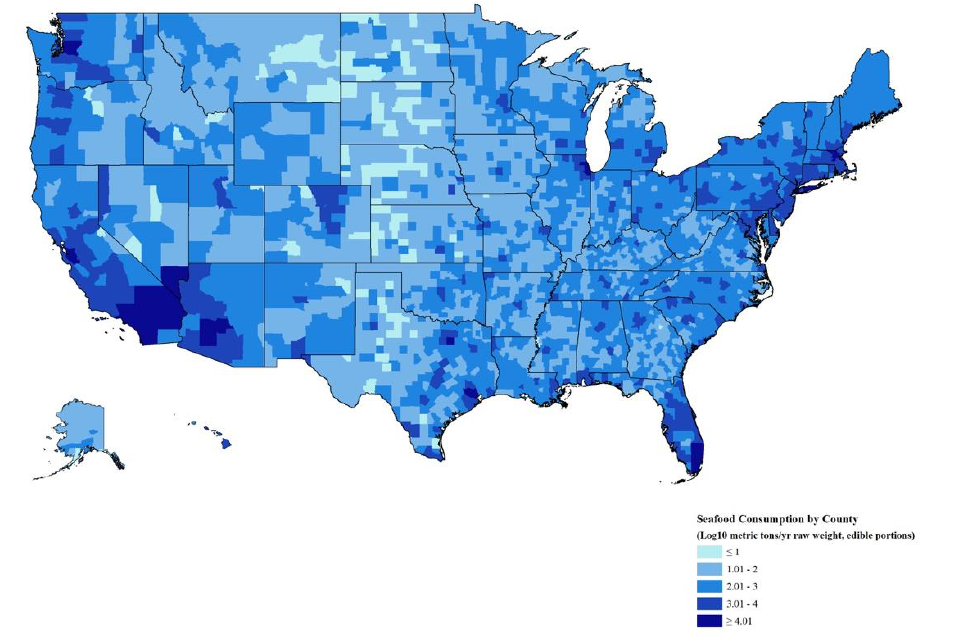
/ yr raw weight, edible 10 metric tons